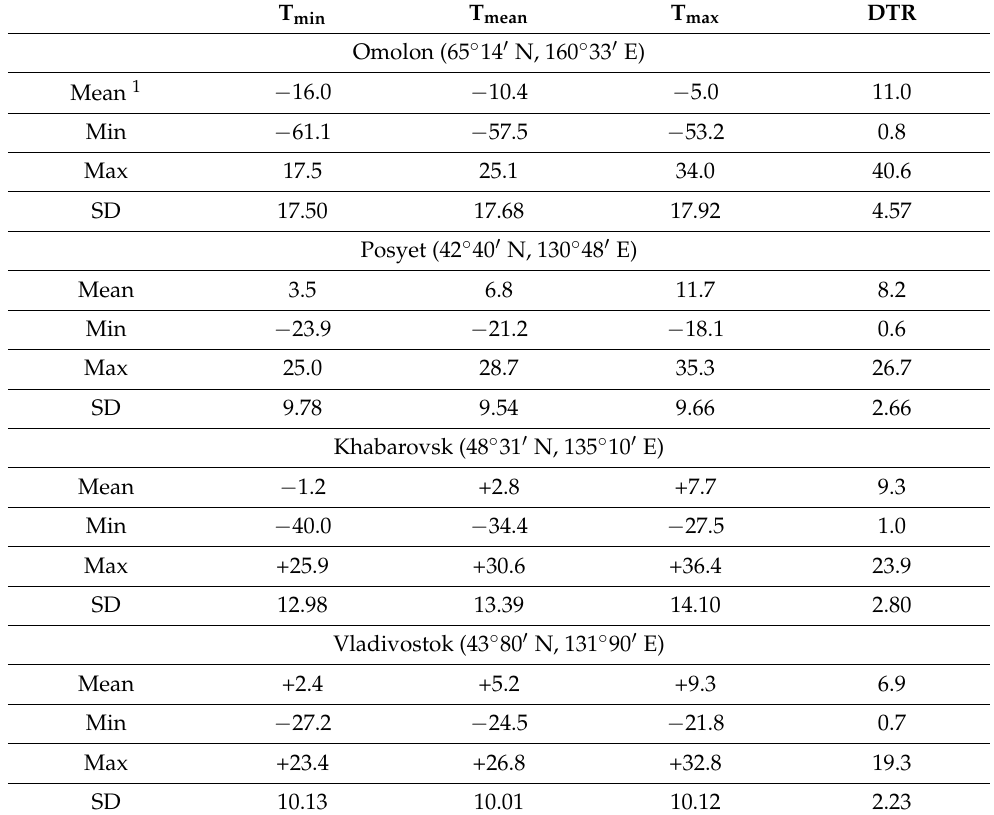
Table 1. Yearly statistics of minimum ( T min ), mean ( T mean ), and maximum ( T max ) air temperature, and diurnal temperature range (DTR), ◦ C, for the locales at the Russian Far East, 2000–2019. T min T mean T max